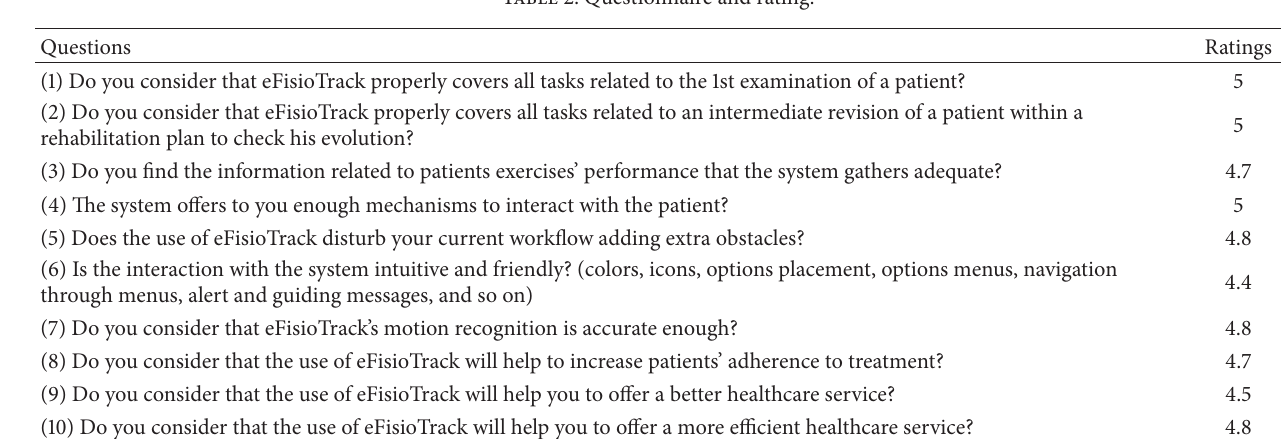
Table 2: Questionnaire and